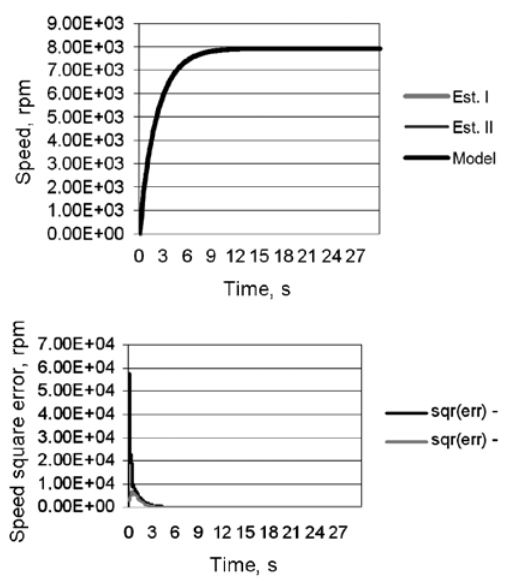
Fig. 3. Drive speed: model as the relation model, Est. I – sqr(err)-I, sqr(err)-II – related square error of speed for